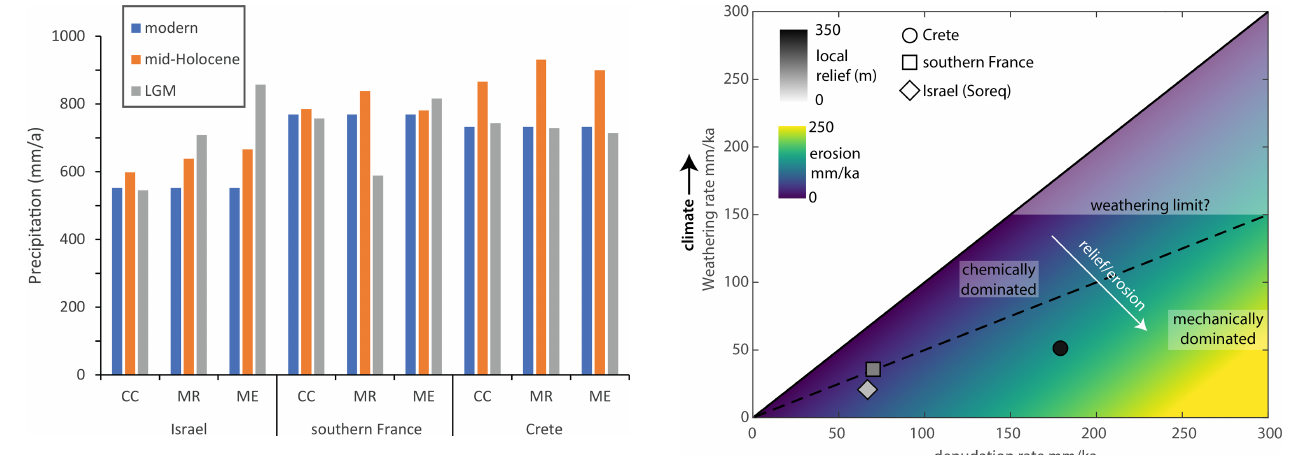
Figure 5. Comparison of modern and paleo-precipitation rates from climate models for all areas with published catchment-averaged de- nudation rates. For three different WorldClim paleo-climate models (CC, MR, ME) (Fick and Hijmans, 2017), paleo-precipitation val- ues were extracted for all sampled 36 Cl sampling locations, aver- aged for each region and compared to modern precipitation rates. LGM – last glacial maximum.